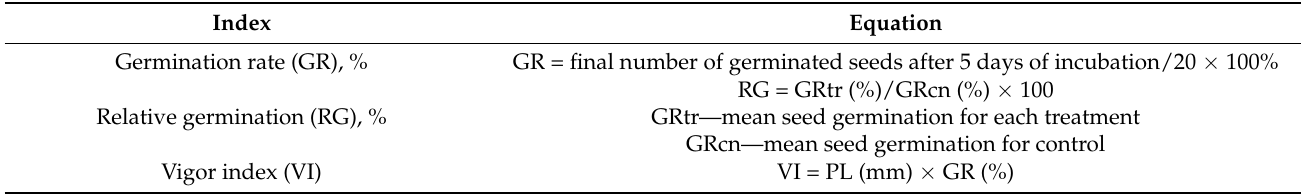
Table 6. Calculation of germination rate (GR), relative germination (RG) and vigor index (VI) of L. sativa and L. sativum